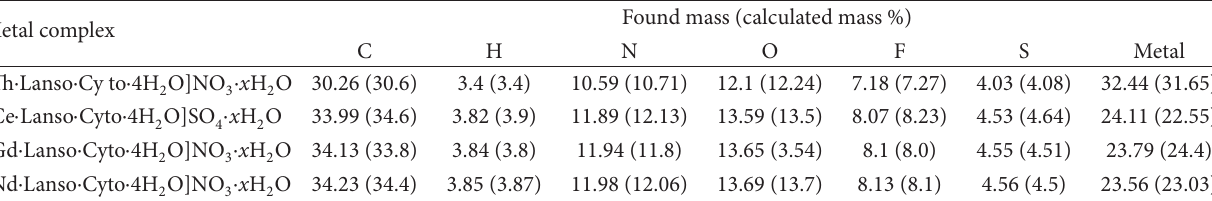
T 4: Elemental analysis of mixed ligand complexes of Lanso and